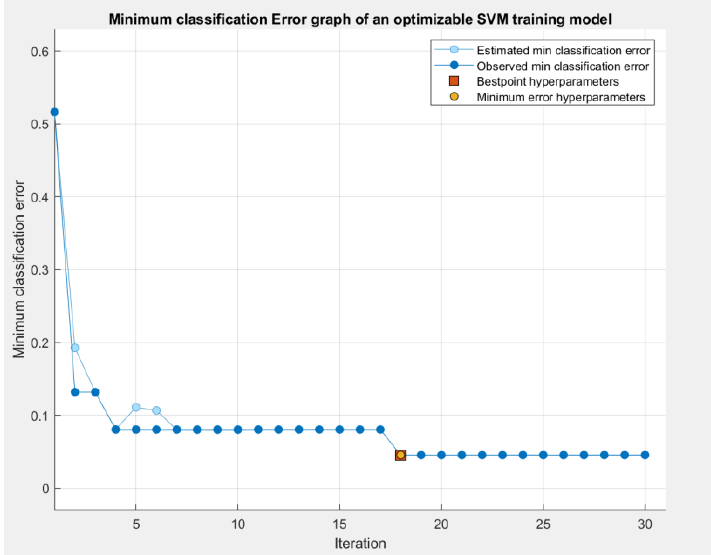
Figure 8. Minimum classification error diagram.